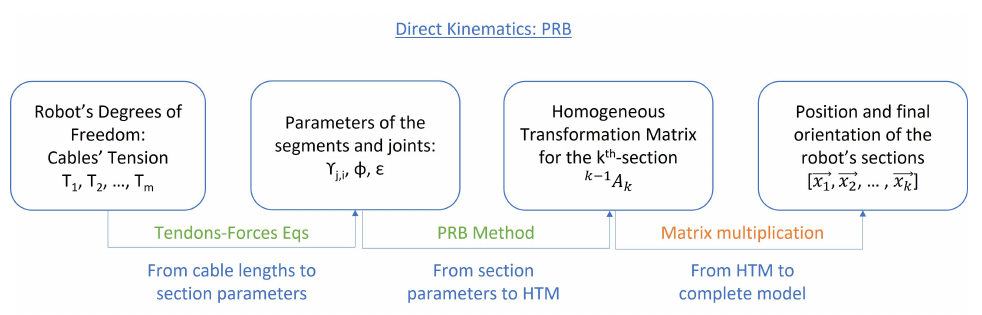
Figure 15. PRB conceptual diagram.